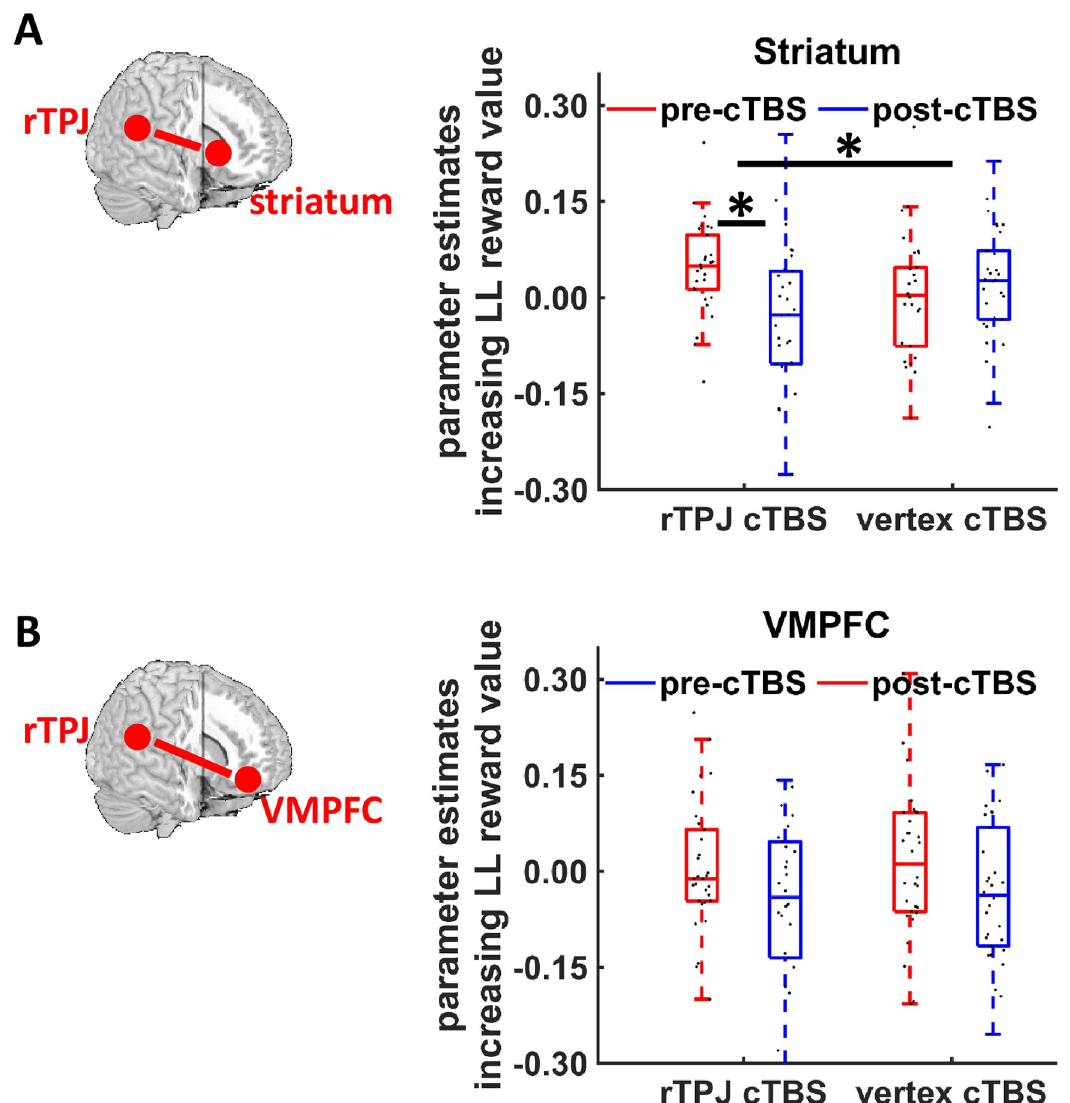
Fig 5. Effects of rTPJ cTBS on connectivity between rTPJ and (A) striatum as well as (B) VMPFC. (A) Disrupting rTPJ with cTBS reduced LL-value–related coupling between rTPJ and striatum. Coupling was significantly reduced in the post-cTBS relative to the pre-cTBS session only following rTPJ, not vertex, cTBS. This finding suggests that the rTPJ modulates neural value signals during intertemporal choice. (B) We observed no significant cTBS effect on VMPFC activation. Black dots show individual parameter estimates. Asterisks indicate significant effects ( p < 0.05). The underlying data for this Figure can be found in S1 Data. cTBS, continuous theta-burst stimulation; LL, larger-later; rTPJ, right temporoparietal junction; VMPFC, ventromedial prefrontal